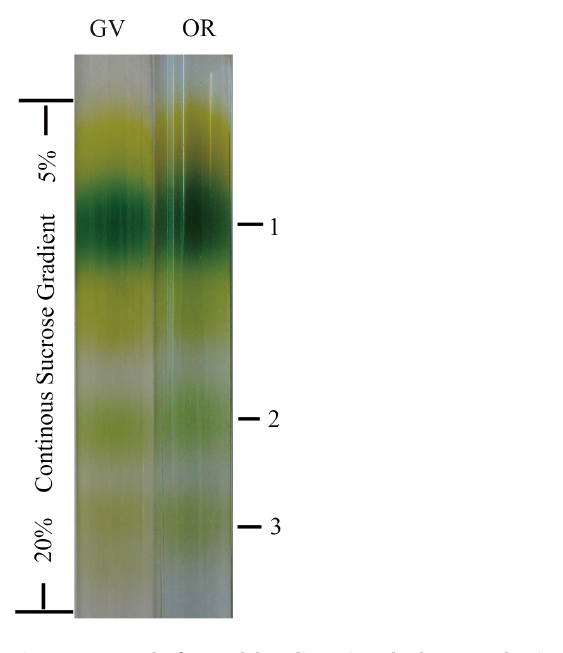
Figure 6. Bands formed by dissociated photosynthesis com- plexes. Purified thylakoid membranes were solubilized by a mild detergent DM ( n -dodecyl- b -D-maltoside). Subsequently, the continuous sucrose gradient (from 5% to 20%, w/v) ultracentrifugation was used to spatially fractionate the complexes. Three green bands were formed during continuous sucrose gradient ultracentrifugation, namely band 1, 2 and 3 from top to down.